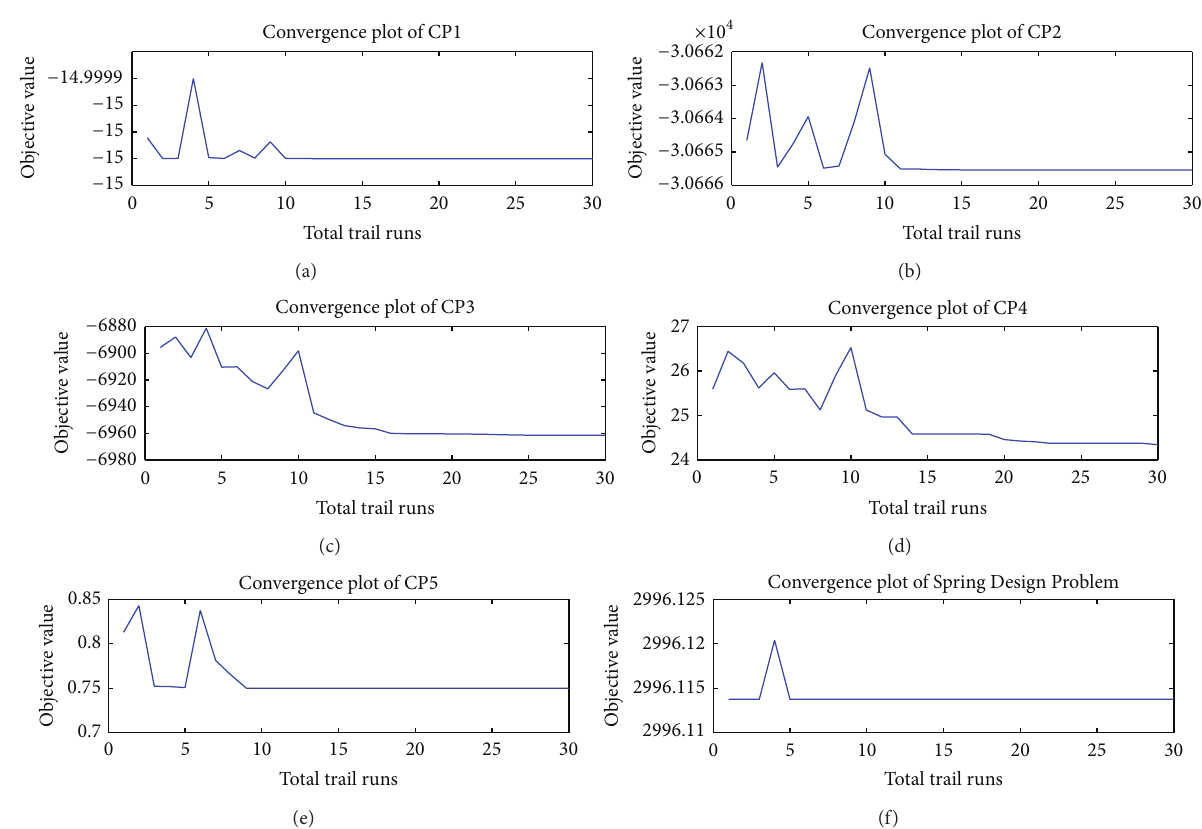
Figure 4: Performance of SbPPA on unconstrained global optimization problems.